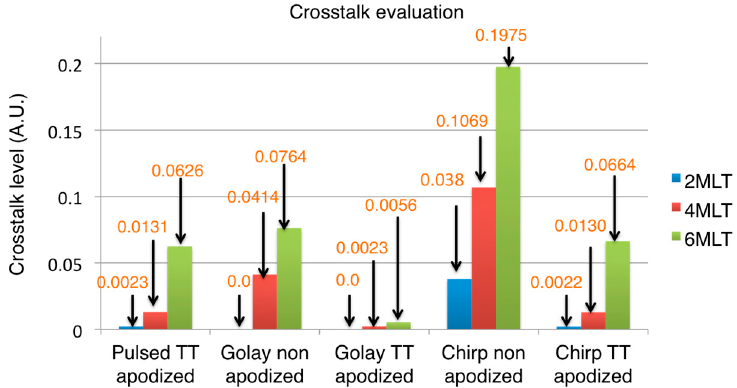
Figure 9. Crosstalk evaluation of different MLT schemes. TT: Tukey ( α = 0.5)-Tukey ( α = 0.5) apodization scheme.